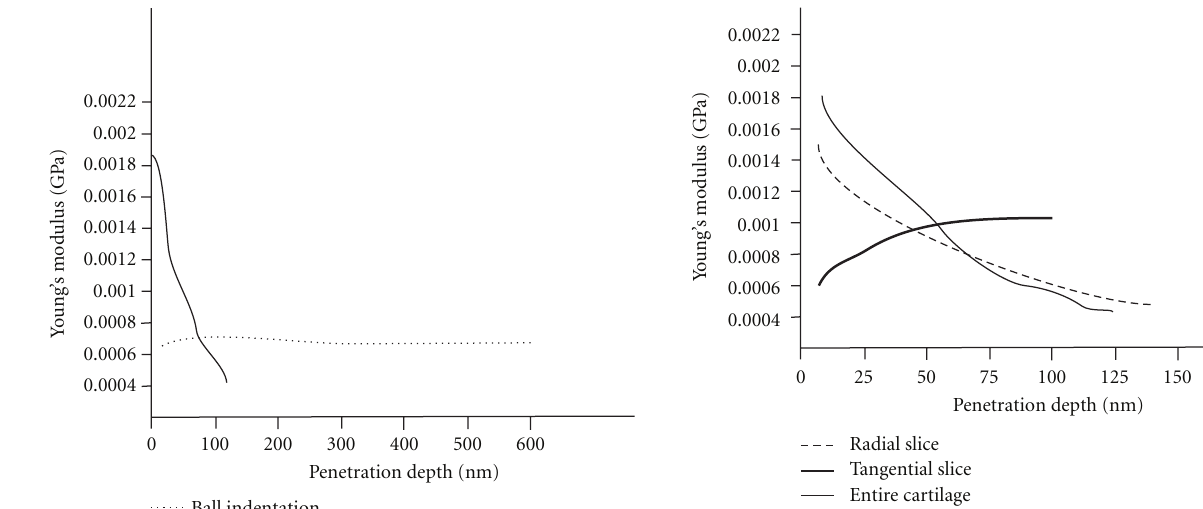
Figure 6: Young’s modulus versus indenter penetration depth for the entire cartilage surface at di ff erent scale levels of measurement.